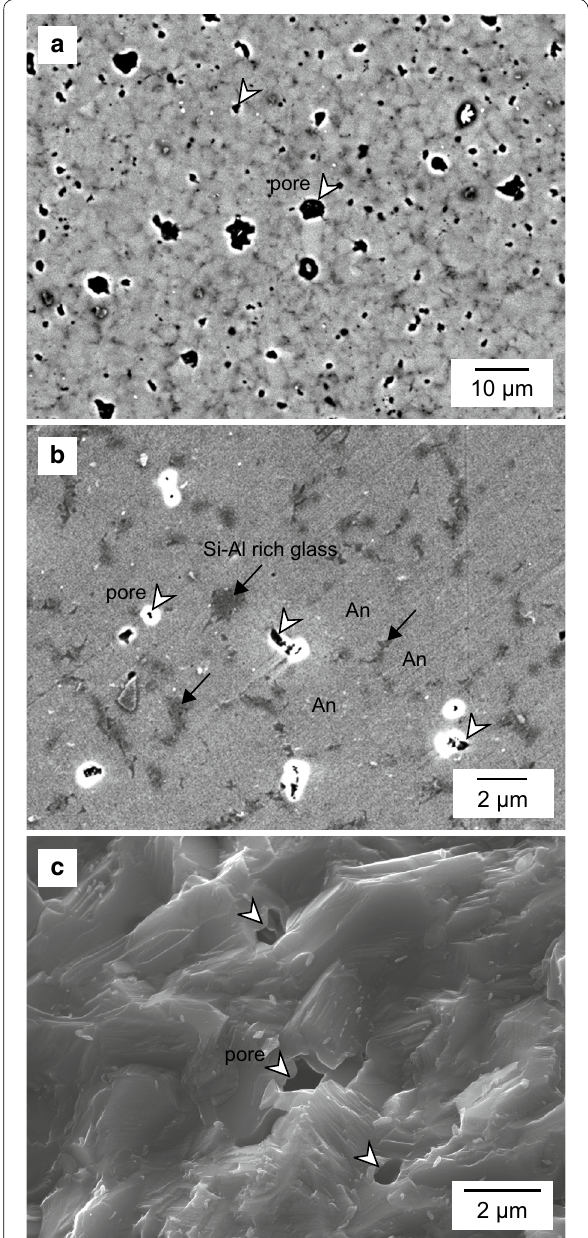
Fig. 1 Characteristics of sintered polycrystalline anorthite 100 used as the starting material for the deformation experiments. a BSE image of the thin section. Anorthite grains with a size of 3 μm (light gray) are surrounded by silica‑ and aluminum‑rich glass (dark gray), which are clearly observed in ( b ). Small (~ 2 μm) and large pores (~ 5 μm) are black. b Enlarged image of the thin section. Glass materials (dark gray) with a 5 vol% developed along the anorthite grain contacts (light gray). c Secondary electron image of a broken surface of the start‑ ing material. Representative pores, anorthite grains, and silica‑ and aluminum‑rich glass are